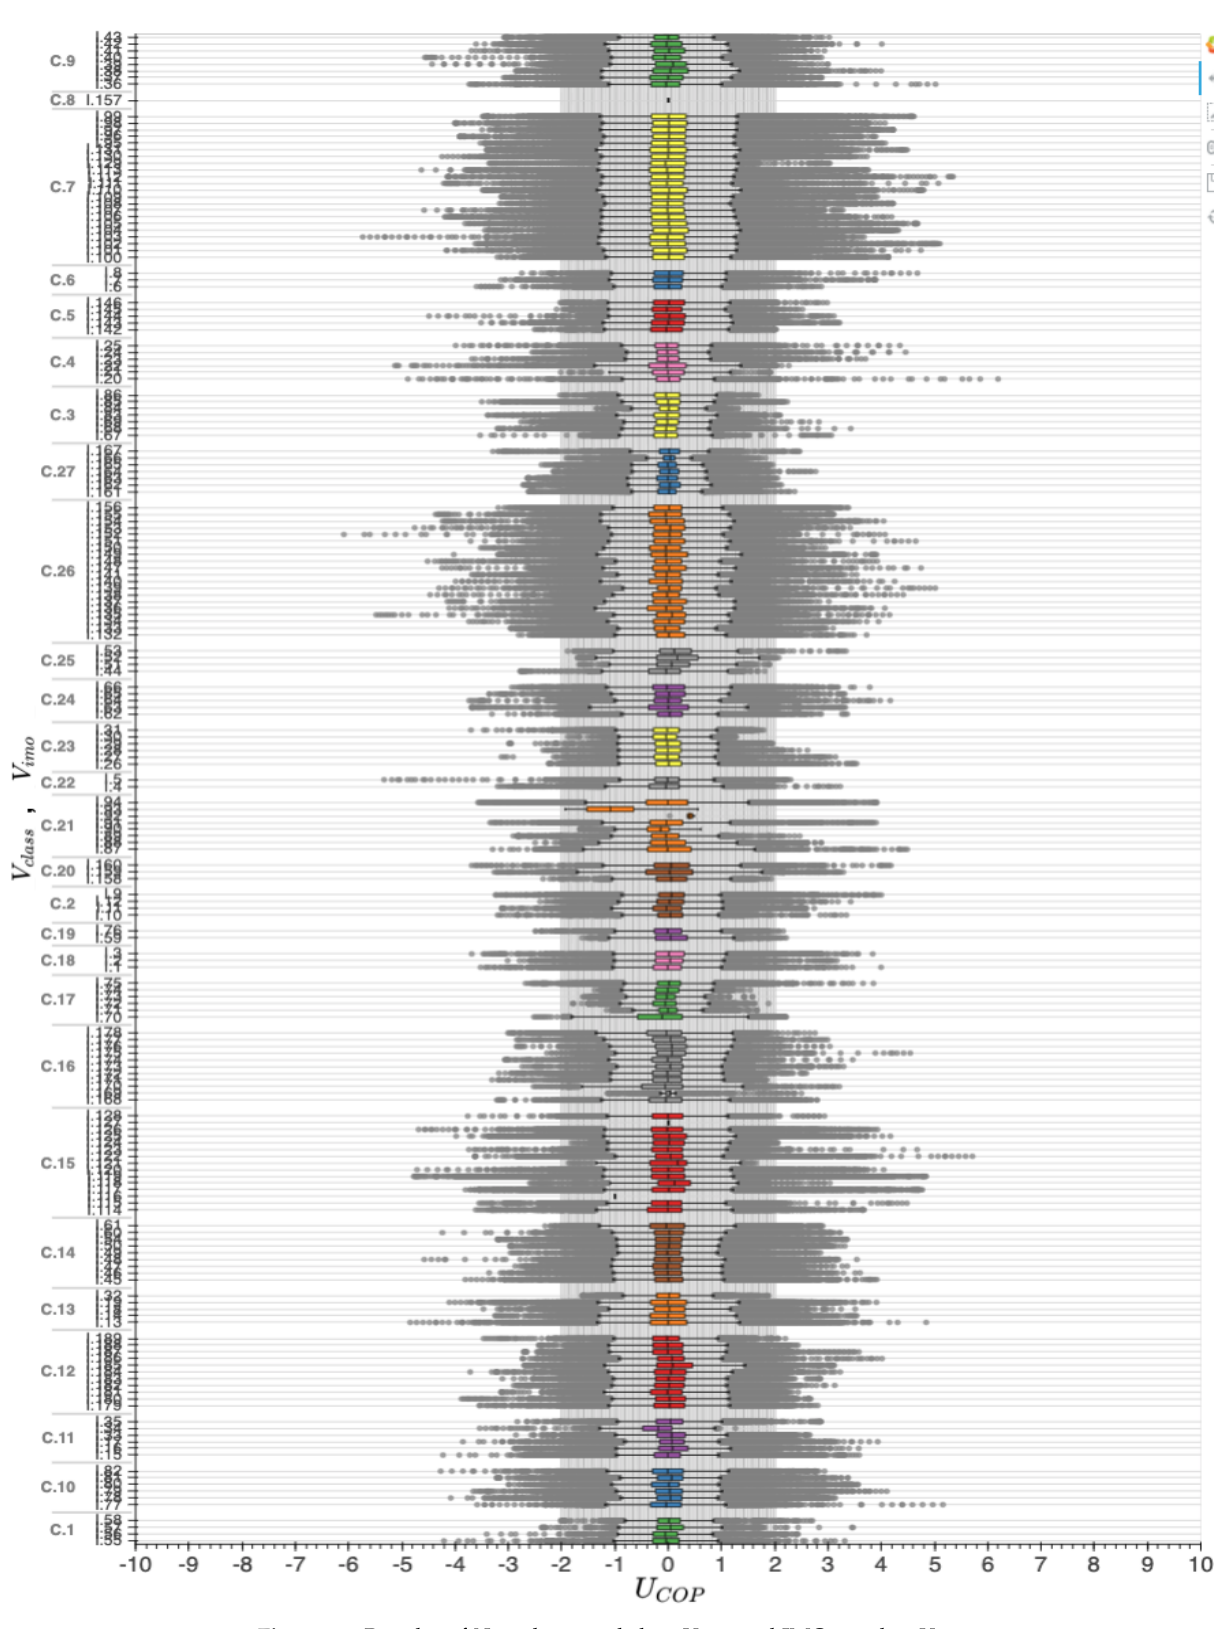
Figure 17. Boxplot of U COP by vessel class V class and IMO number V imo